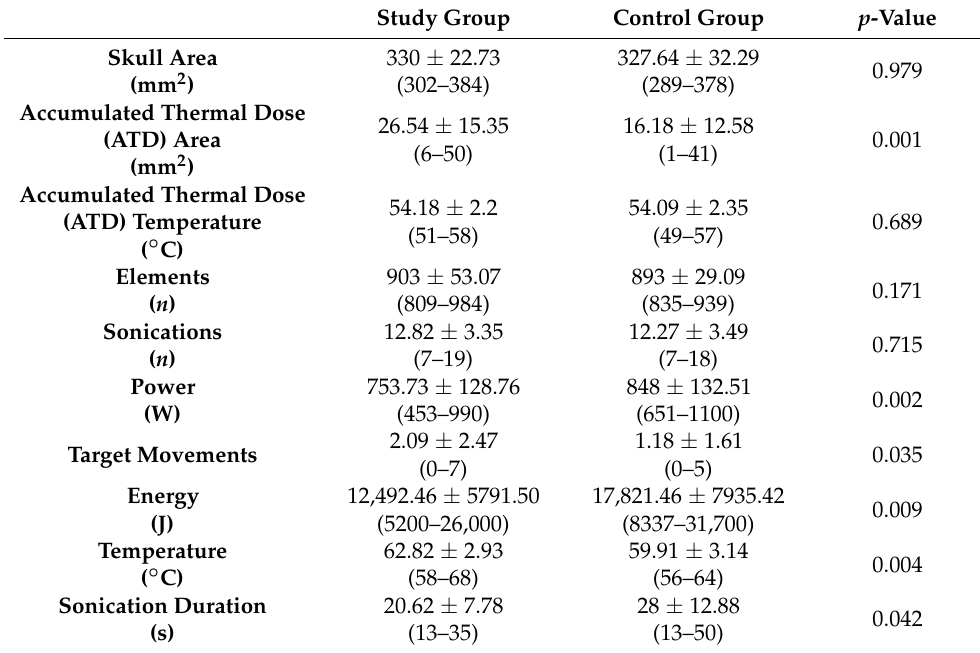
Table 3. Procedural parameters in the study group and control